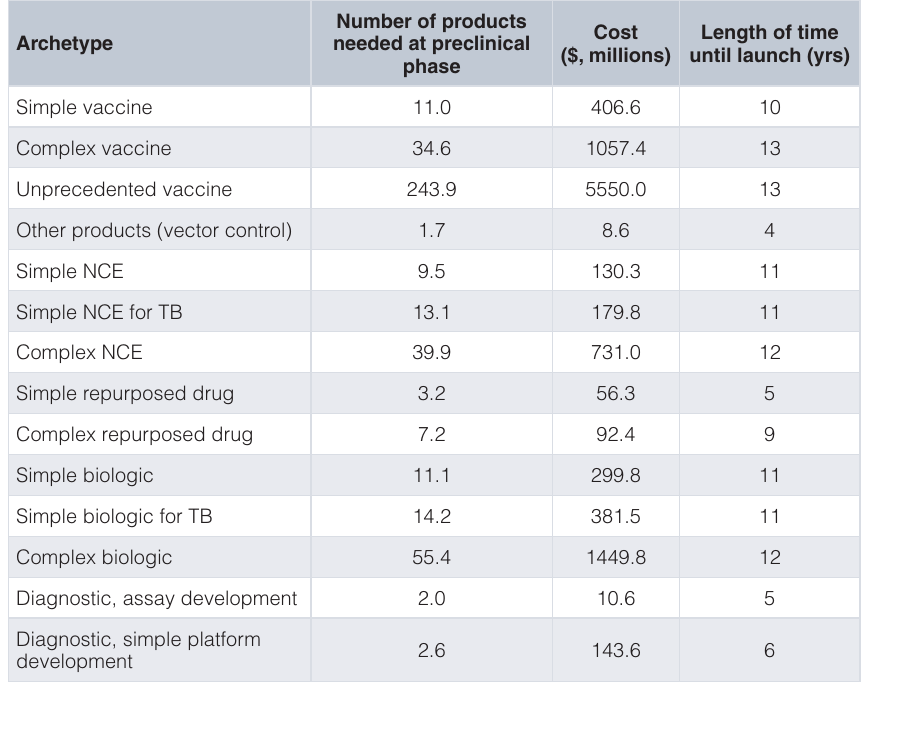
Table 11. Estimated additional costs to launch 18 “missing” products.